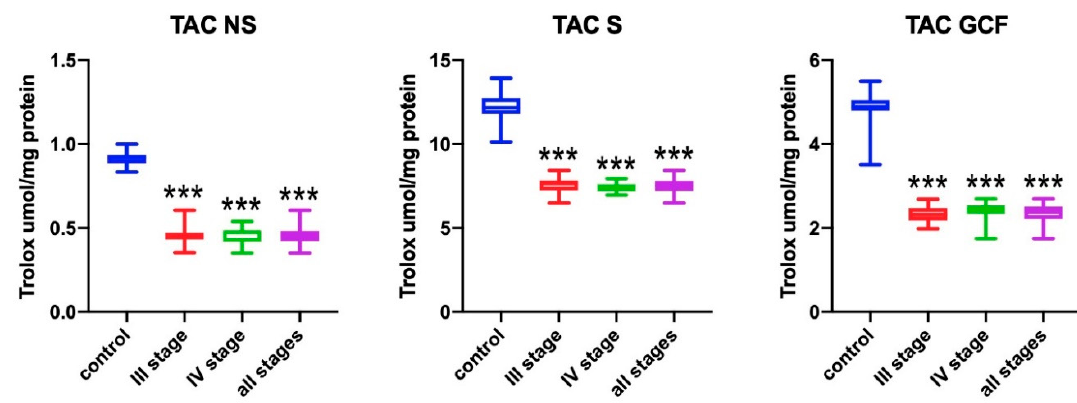
Figure 2. Concentrations of total antioxidant capacity (TAC) in non-stimulated saliva (NS), stimulated saliva (S), and gingival crevicular fluid (GCF) in all patient groups. *** p < 0.001 vs. control group.